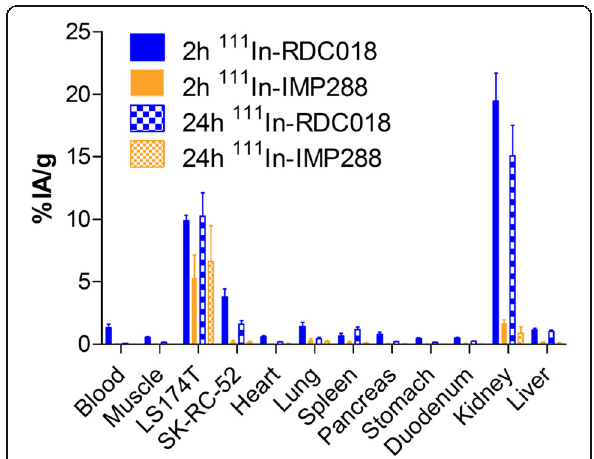
Fig. 1 Biodistribution profiles of 111 In-RDC018 and 111 In-IMP-288 at 2 h and 24 h p.i. after pretargeting with 8 nmol TF2 in BALB/c nude mice, showing specific tumor uptake in the s.c. CEA-expressing LS174T tumor and pronounced renal